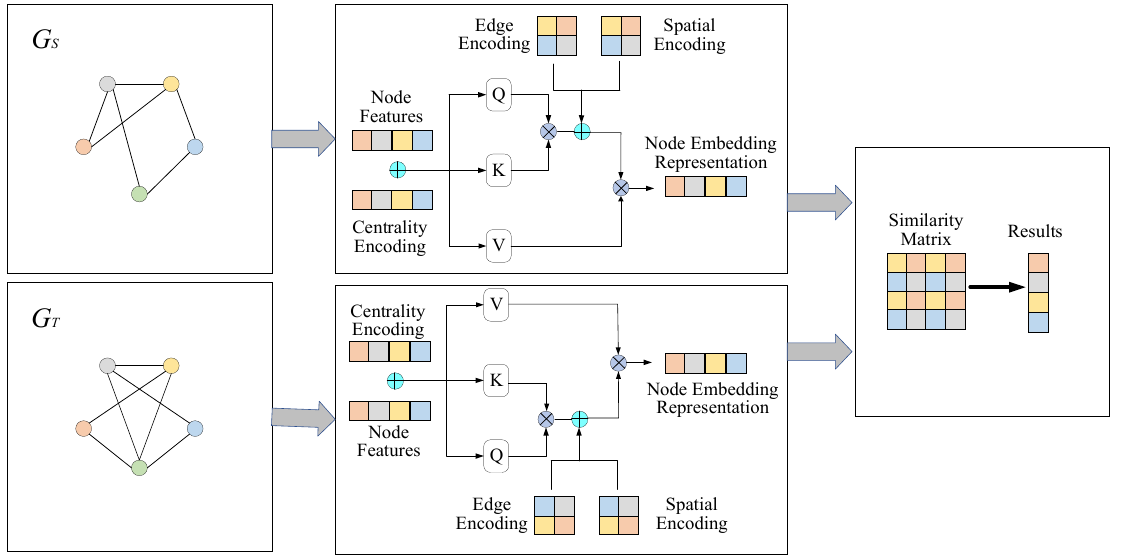
Figure 1. The overall framework of TUMA across social networks.